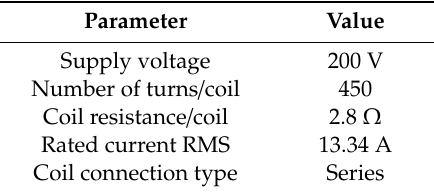
Table 1. Electrical circuit properties.